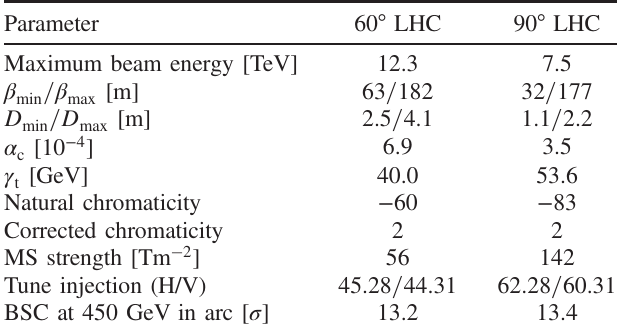
TABLE VI. 60° and nominal 90° LHC injection optics param- eters at 450 GeV, using aperture parameters described in Sec. III. The maximum beam energy considers only MQ gradient limits.